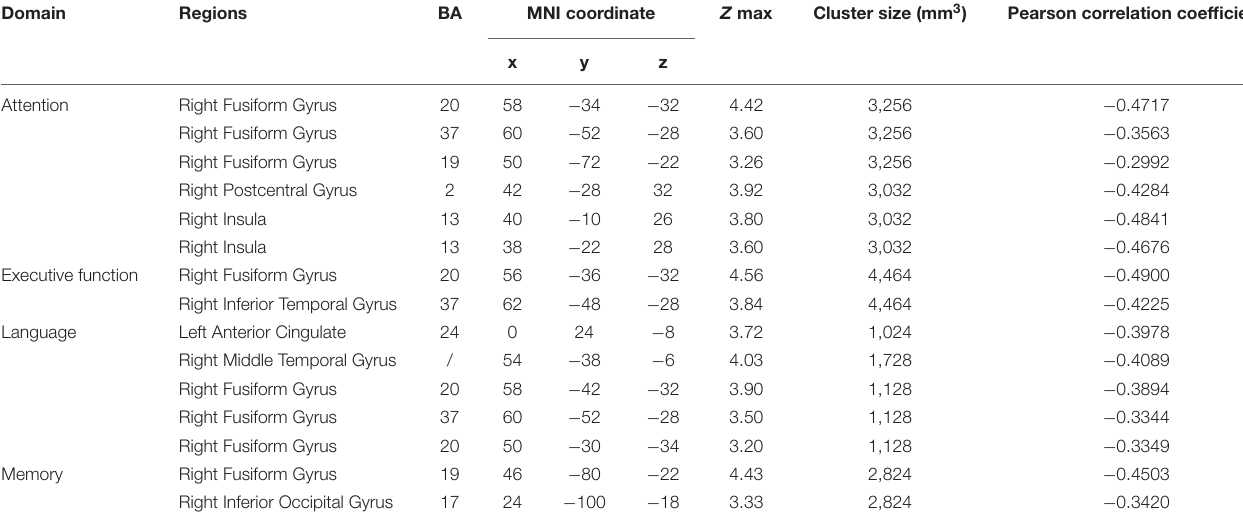
TABLE 3 | Brain regions in the 84 patients with MSA exhibiting negative correlations between the Z -score of cognitive domains and regional brain metabolism adjusting for education and UPDRS score.